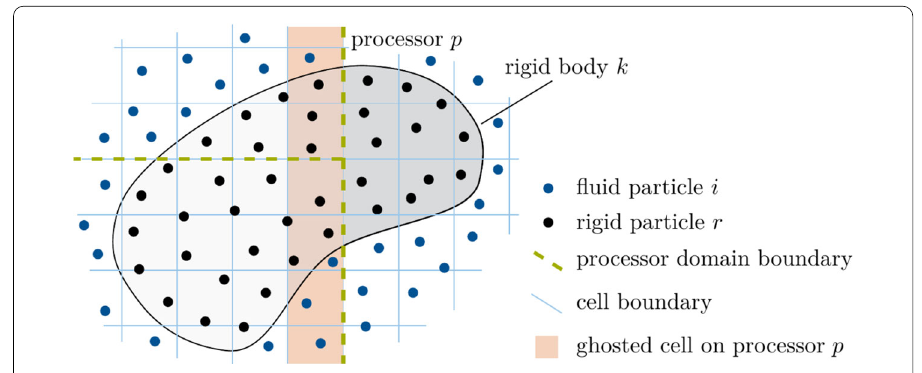
Fig. 2 A fluid–solid interaction problem consisting of a rigid body k with affiliated rigid particles r and surrounding fluid particles i distributed over several processors p according to a spatial decomposition